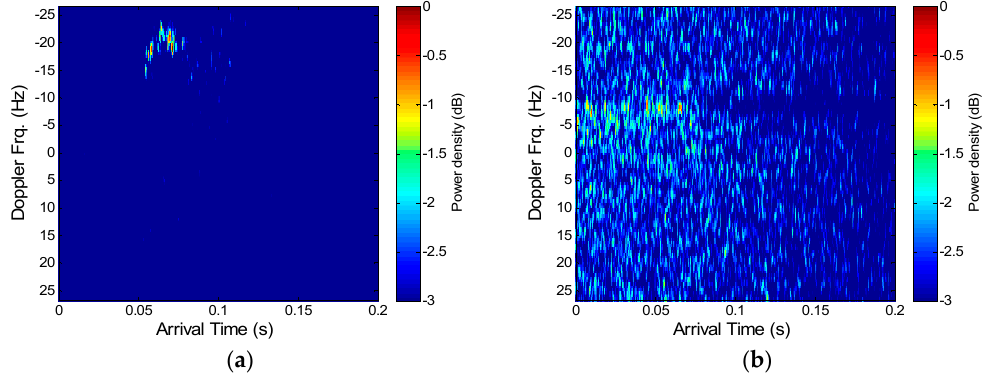
Figure 14. Scattering function for the Doppler frequency estimation for ( a ) the first lake trial and ( b ) the second lake trial.